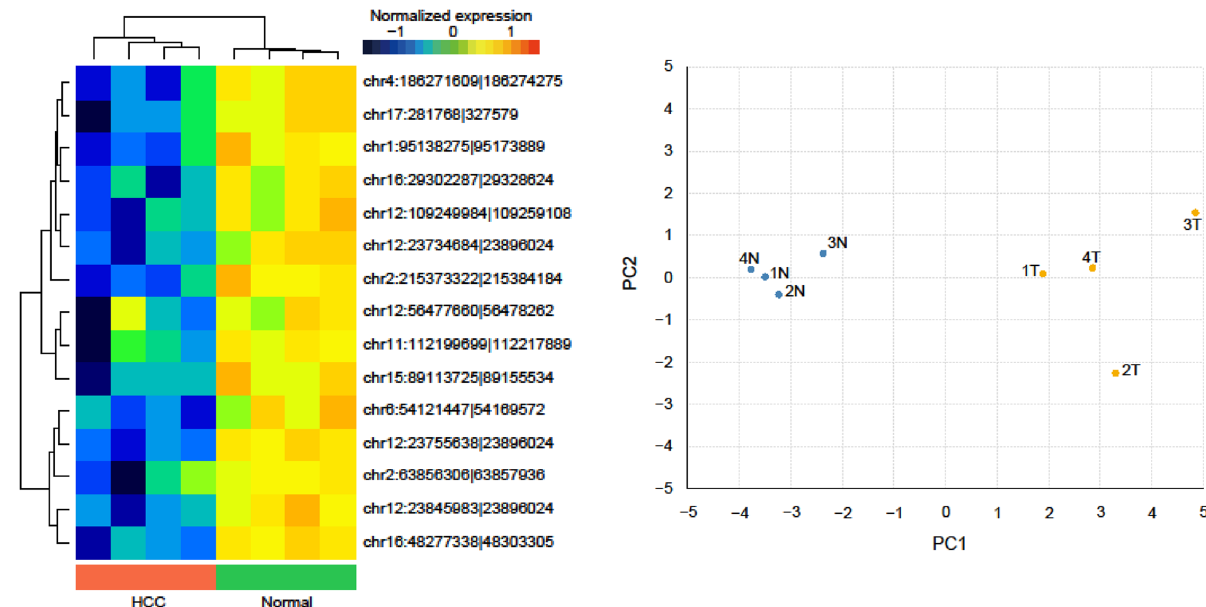
Figure 1. Differential expression of circRNAs between HCC and background normal liver. The figure is prepared using R software (version 3.5.3, https ://www.r-proje ct.org/) 43 and Gplots (version 3.1.1, https ://githu b.com/talga lili/gplot